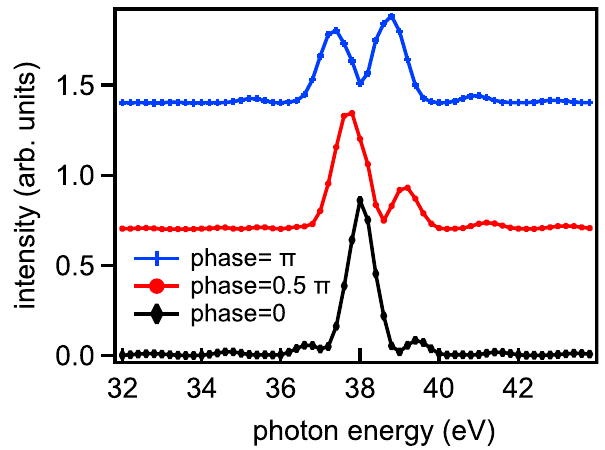
Fig. 2 Measured spectral intensity as a function of photon energy with the undulator gaps optimised for 38 eV emission, and three values of the phase setting. Lower curve: phase = 0 rad; centre curve, phase = 0.5 π rad; top curve, phase = π